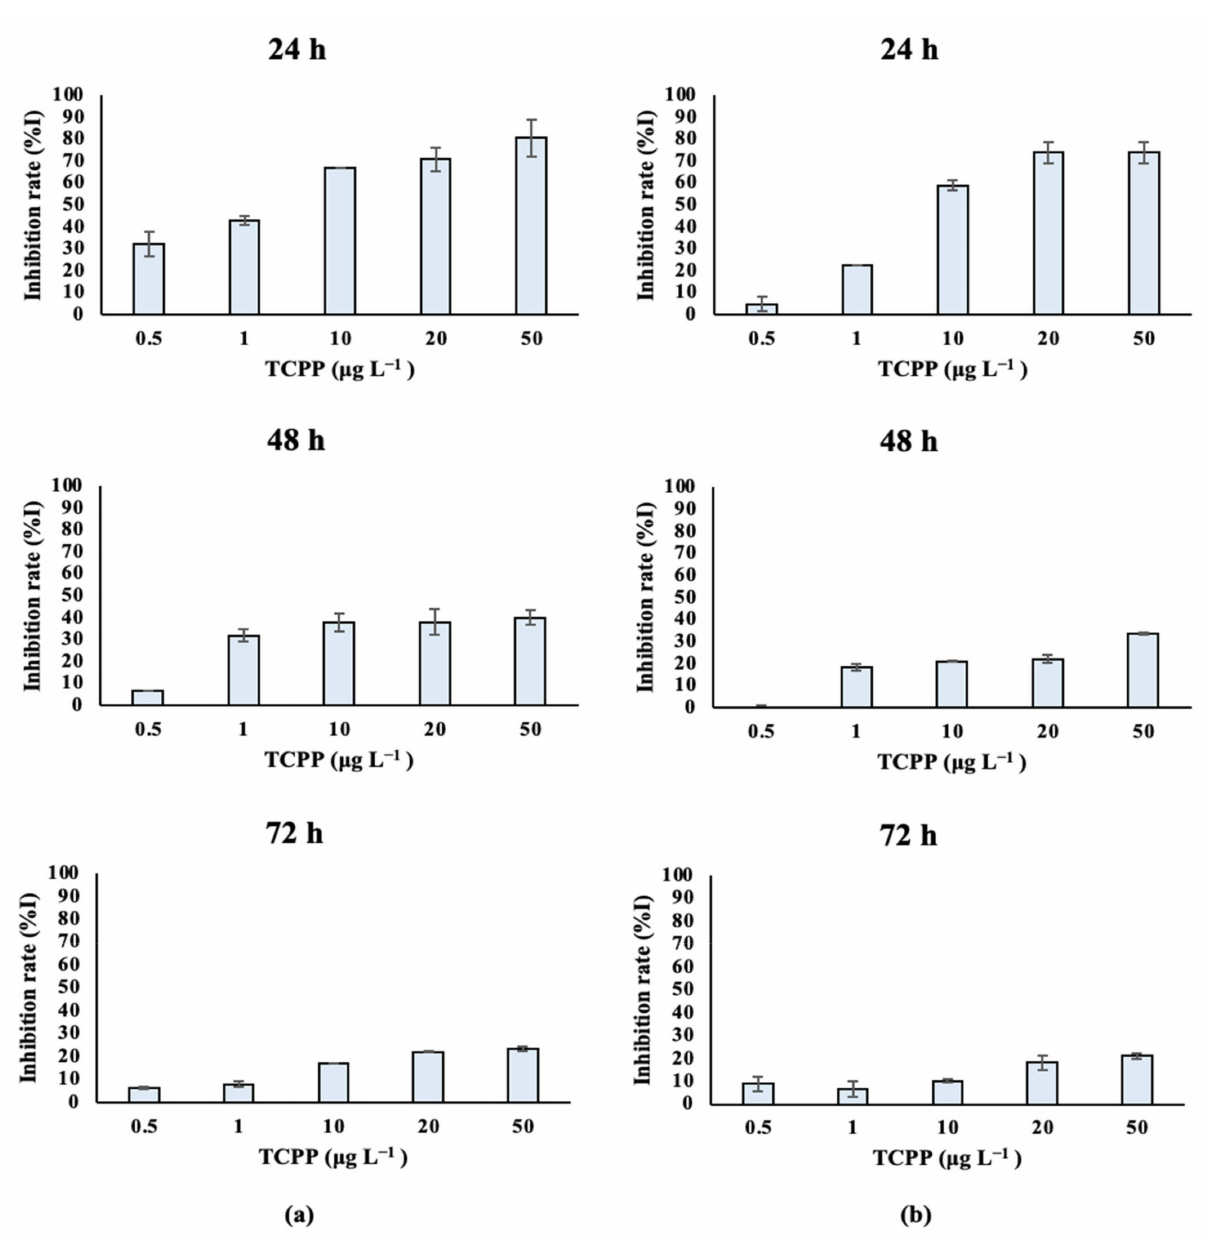
Figure 4. Inhibition of ( a ) Dunaliella tertiolecta and ( b ) Tisochrysis lutea growth rate (%I) after exposure to TCPP for 24, 48 and 72